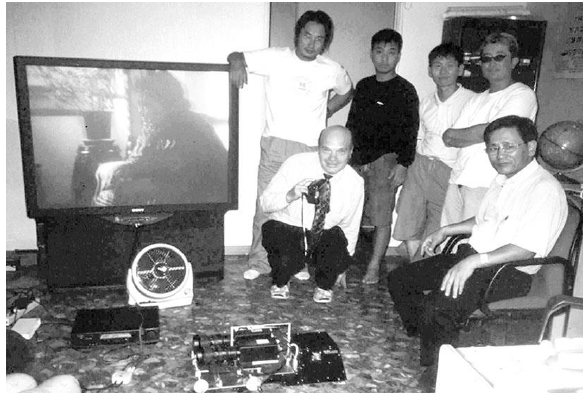
Figure 5. Early visit of the 1st author at the HAN Archive of 3D